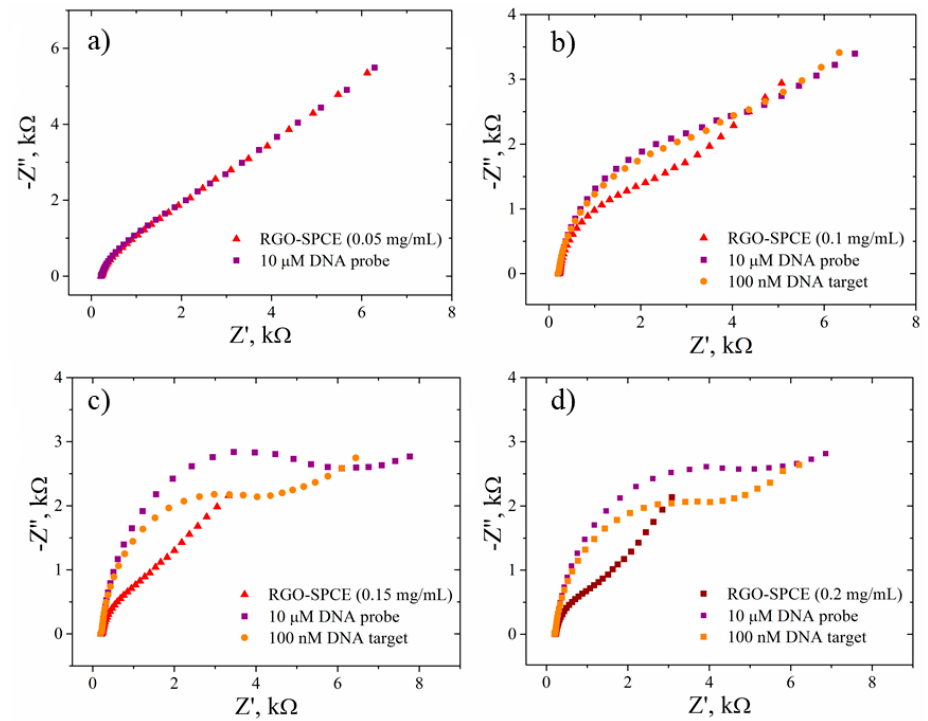
Figure 12. EIS measurements (Nyquist spectra) recorded in 1 mM [Fe(CN) 6 ] 3 − /4 − , 0.1 M KCl, for RGO-SPCEs based on ( a ) 0.05 mg/mL; ( b ) 0.1 mg/mL; ( c ) 0.15 mg/mL; and ( d ) 0.2 mg/mL GO dispersions, after adsorption of ssDNA probe (10 µM) and hybridization with 100 nM DNA target.